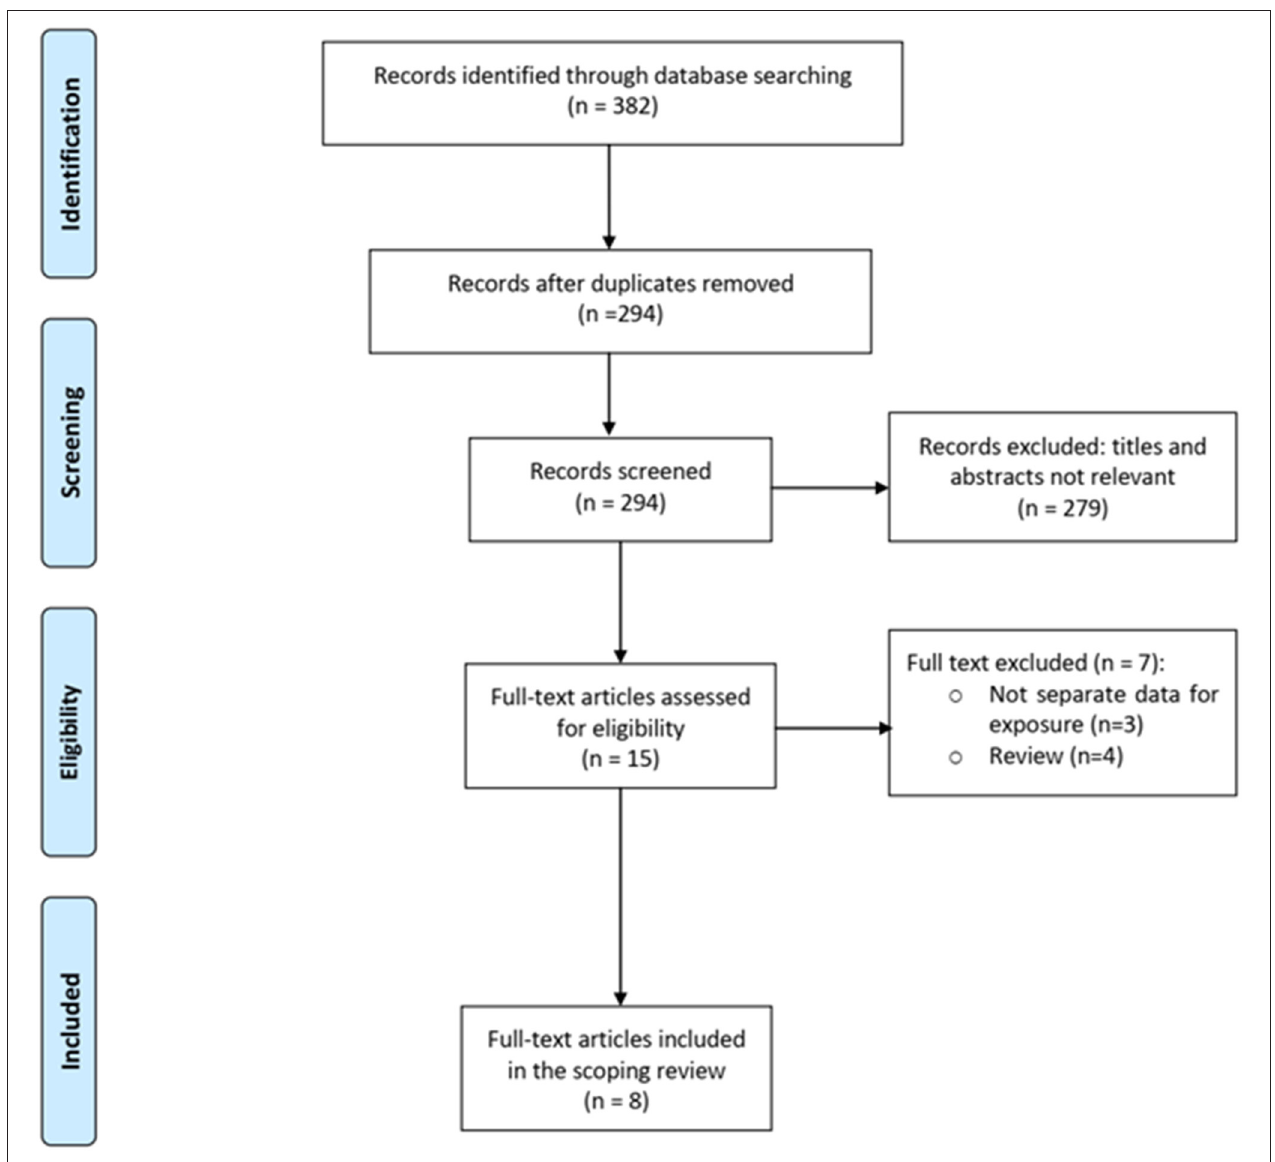
FIGURE 1 | Study flow